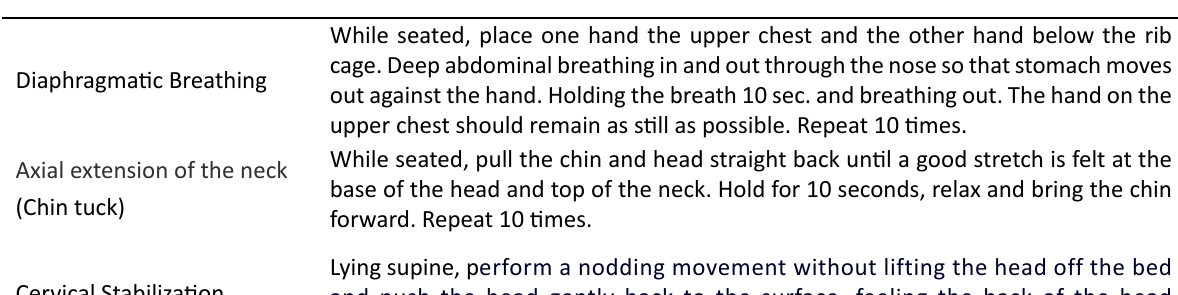
Table 1. The 5x5 Exercise Program